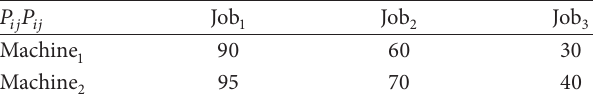
Table 1: Jobs’ total processing times on machines.